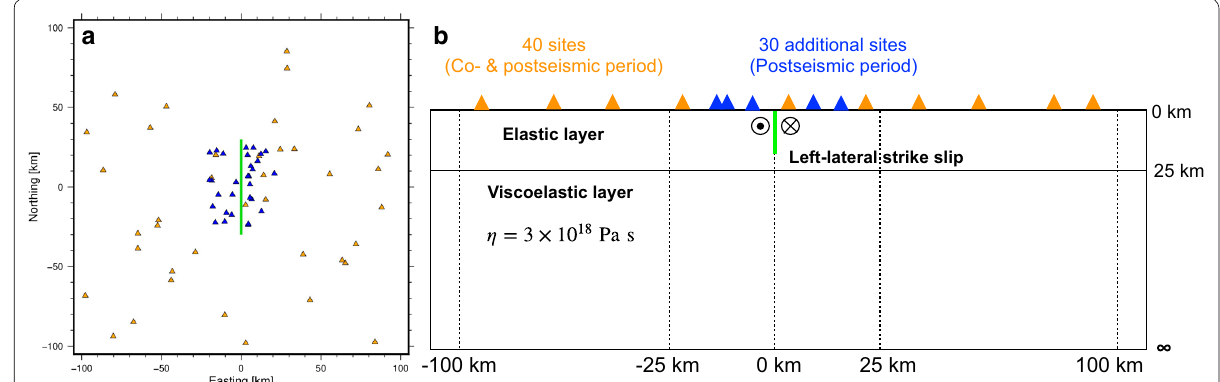
Fig. 1 Site distribution and rheological structure for the strike–slip case. a Synthetic site distribution. Green line represents a fault trace on surface. Orange triangles indicate synthetic GNSS sites for both co- and post-seismic period, while blue triangles indicate those only for post-seismic period. b A schematic image of cross section of rheological structure (the two-layered viscoelastic